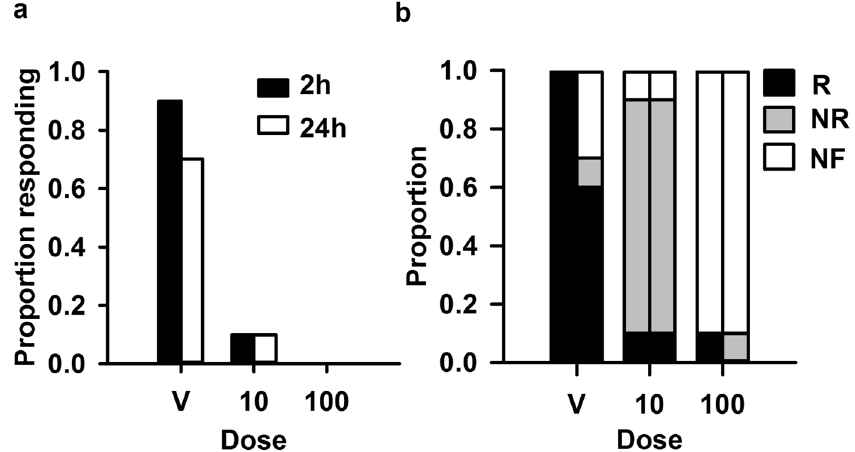
Figure 2. Effect of IMD on escape behaviours. ( a ) Proportion of animals responding to a looming stimulus by jumping or twitching hind legs at 2 and 24 hours after treatment with the vehicle, or 10 ng/g or 100 ng/g IMD. ( b ) Proportion of animals responding to looming stimulus while flying (R), flying but not responding to stimulus (NR), or not flying (NF) at 2 (left columns) and 24 (right columns) hours after treatment with vehicle or